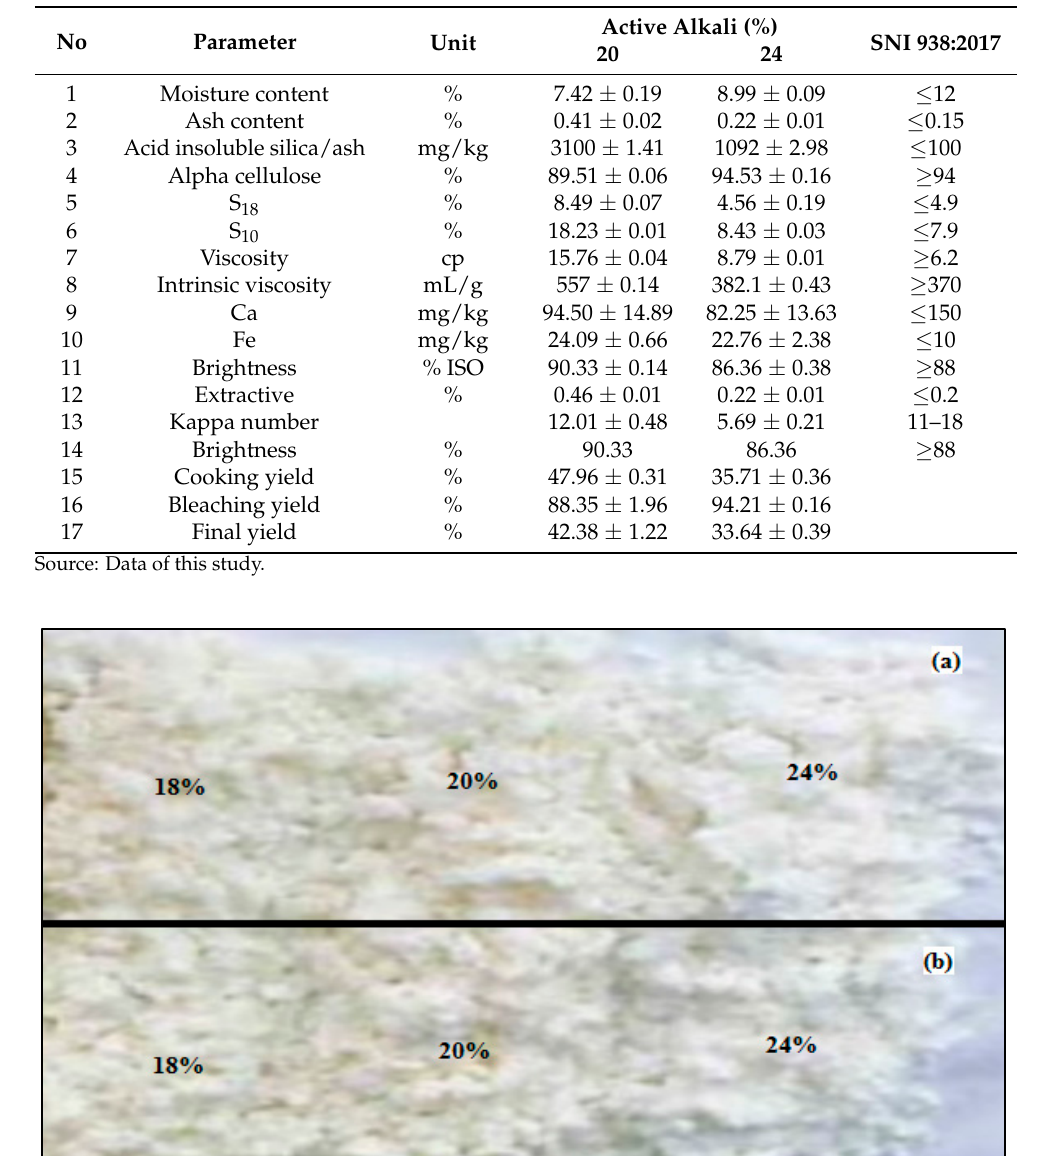
Table 9. Analysis results of dissolving pulp (DP) on stalk-empty fruit bunches (SEFB) fibers.